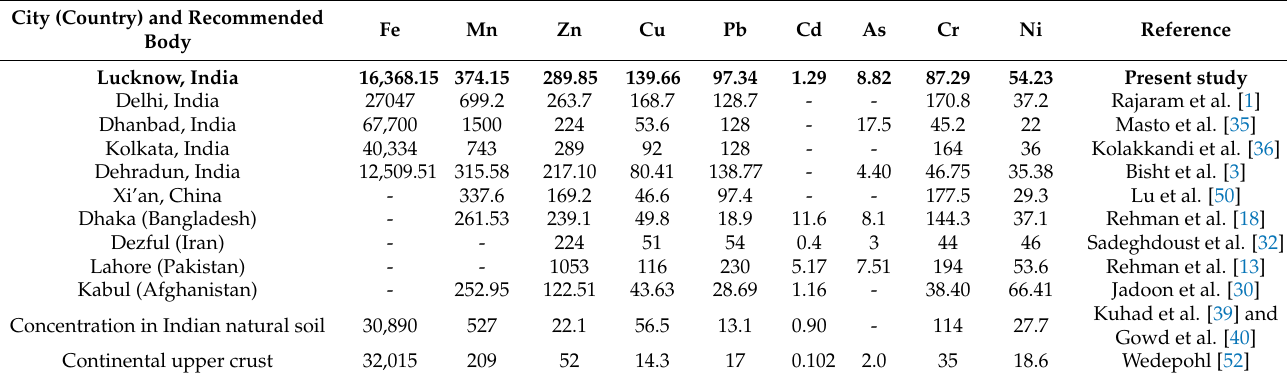
Table 6. Heavy metal concentrations (mg · kg − 1 ) in road dust samples from different regions of India and the